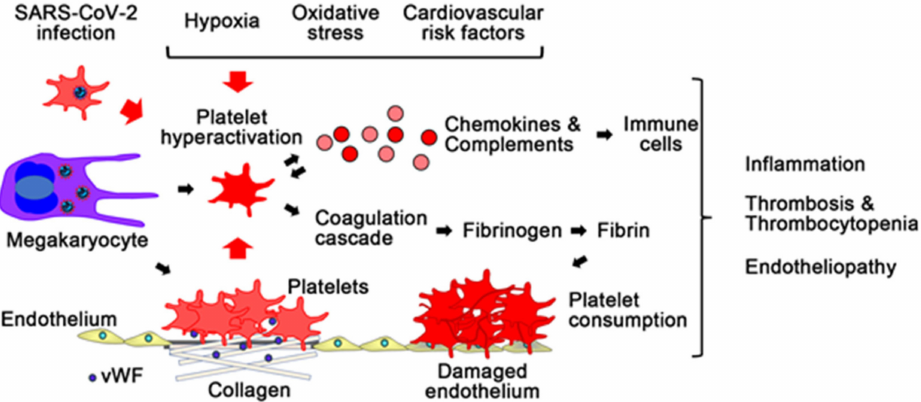
Figure 3. Platelet activation and the coagulation cascade in COVID-19. SARS-CoV-2 infection induces platelet hyperactivation. In COVID-19, platelets are primed to promote proinflammatory responses and activate the coagulation cascade and thrombosis. Hyperactivated platelets release large amounts of chemokines, and activate complements, which leads to increased fibrinogen, the von Willebrand factor (VWF), factor XII, and activation of immune cells. Platelet hyperactivation by SARS-CoV-2 infection causes inflammation, thrombosis with thrombocytopenia, and endotheliopathy. Hypoxia, oxidative stress, and cardiovascular risk factors might exacerbate these